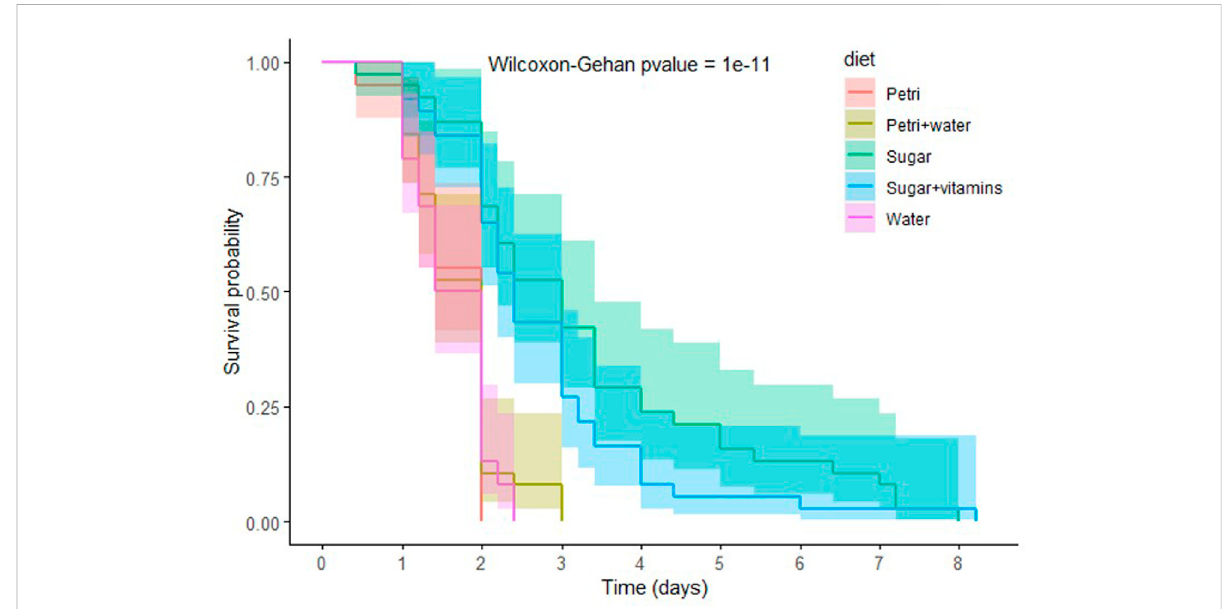
Impactof starvation and totalamino-acid deprivation onaphid survival. Survivalanalysisof A.pisum rearedin Petri dishes, without (Petri, red)or with a moist fi lter (Petri + water, sand), or in feeding chambers containing either water (Water, pink), sugary water (Sugar, green) or sugary water supplemented with vitamins (Sugar + vitamins, blue). Each diet group was composed of 40 aphids. Data were analyzed using the Wilcoxon-Gehan